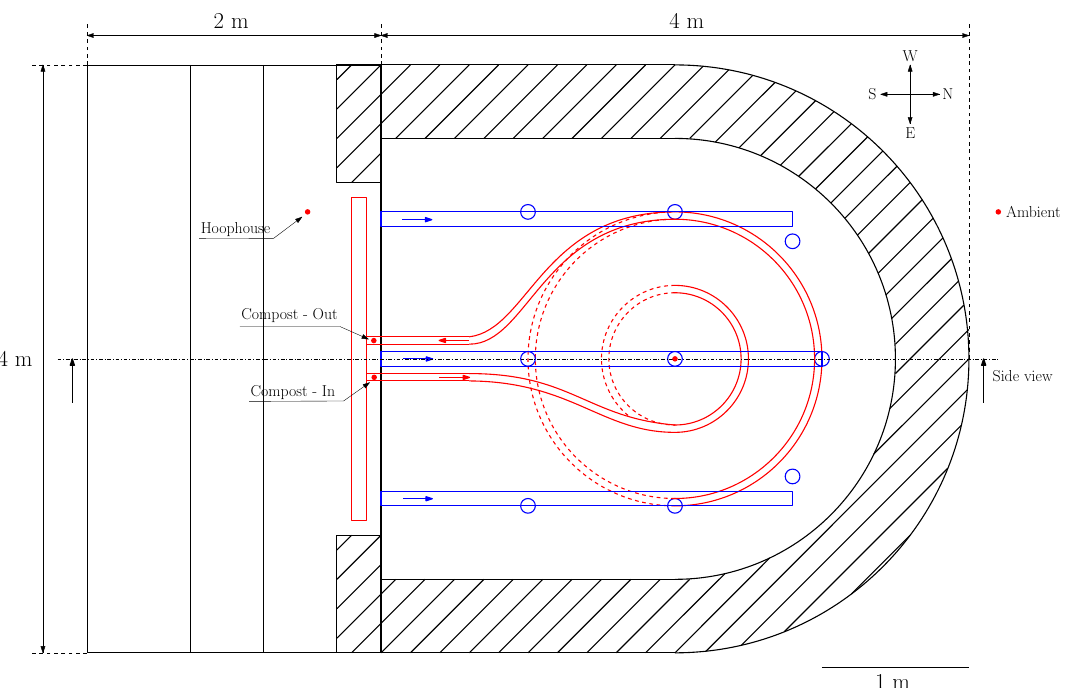
Figure 6. Design of the composting bioreactor: Red—schematic drawing of the CHRS; Blue—aeration system; Shaded region—straw bale thermal insulation.